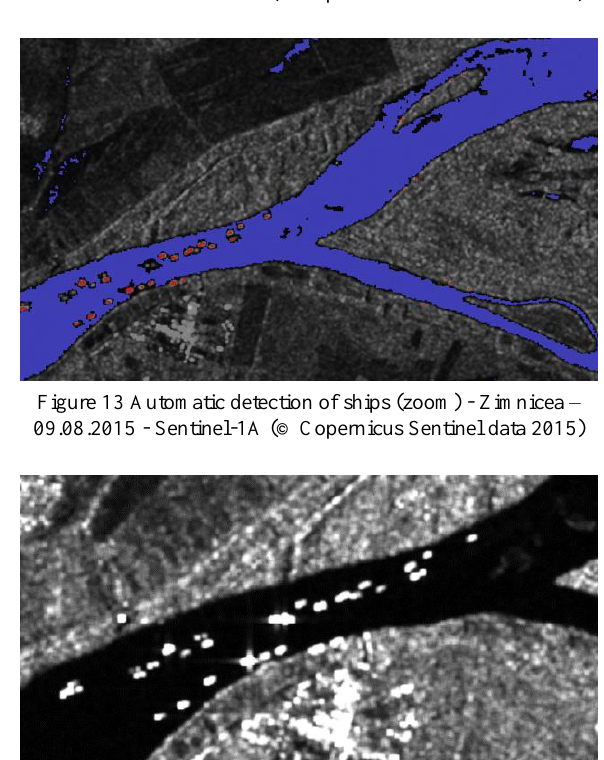
Figure 12. Automatic detection of ships - Zimnicea – 09.08.2015 - Sentinel-1A (© Copernicus Sentinel data 2015)